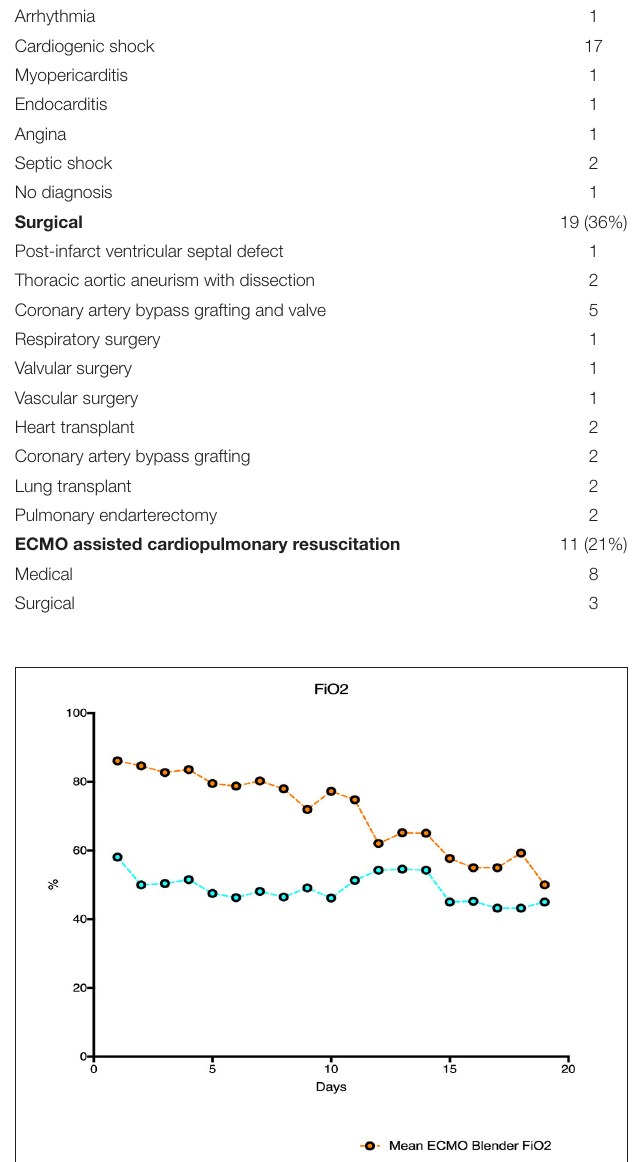
relatively constant during the entire duration of VA ECMO support. Figure 3 shows mean PaO 2 for individual patients during their entire duration of ECMO support. There was a large variability between patients, with mean PaO 2 ranging from 82.7 to 400 mmHg. Two patients who exhibited a mean Pao 2 > 400 mmHg had an outlier effect owing to their short ECMO runs. One died at 27 h and the other was liberated from ECMO at 42